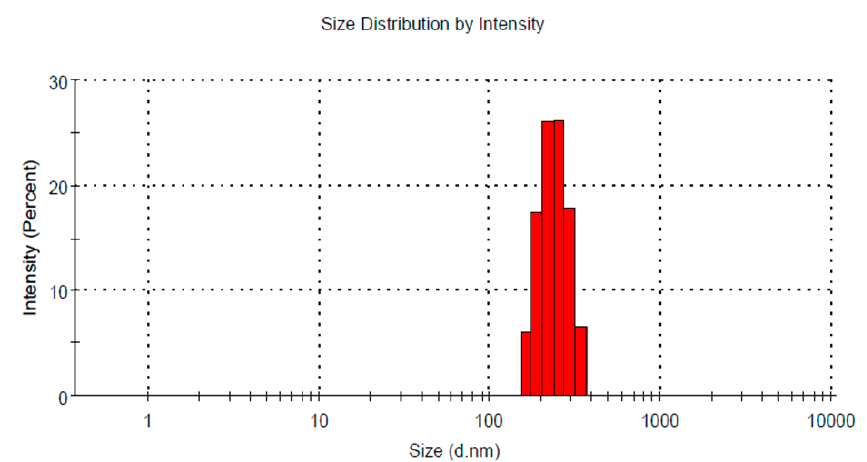
Figure 4. Particle size of optimized FA-SLN formulation.